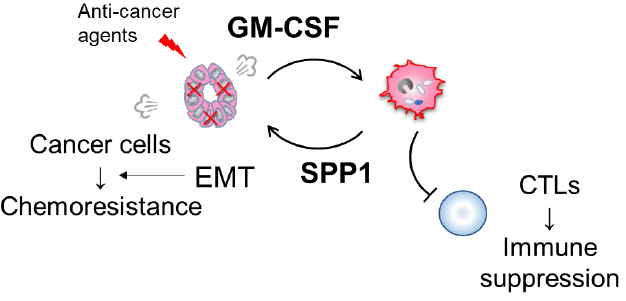
Figure 4. Schematic illustration of possible involvement of the GM-CSF-SPP1 loop in chemoresistance. Anti-cancer agents potentially upregulate GM-CSF secretion from cancer cells. GM-CSF promotes the infiltration of TAMs and a change in TAMs to a protumor phenotype, which in turn induces cancer cell growth and chemoresistance.